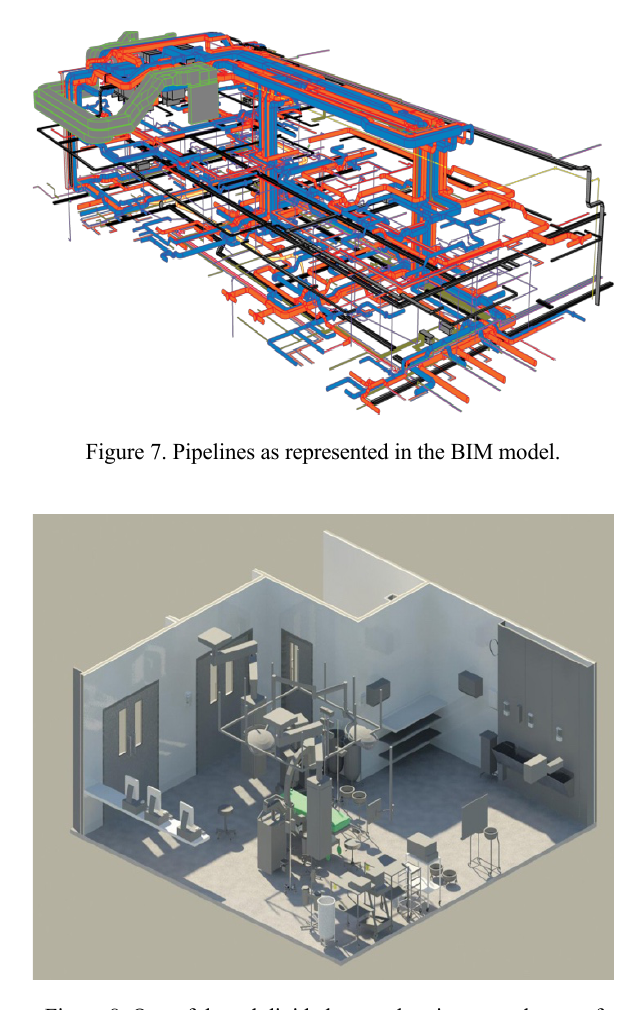
Figure 8. One of the subdivided areas showing some layers of the BIM.